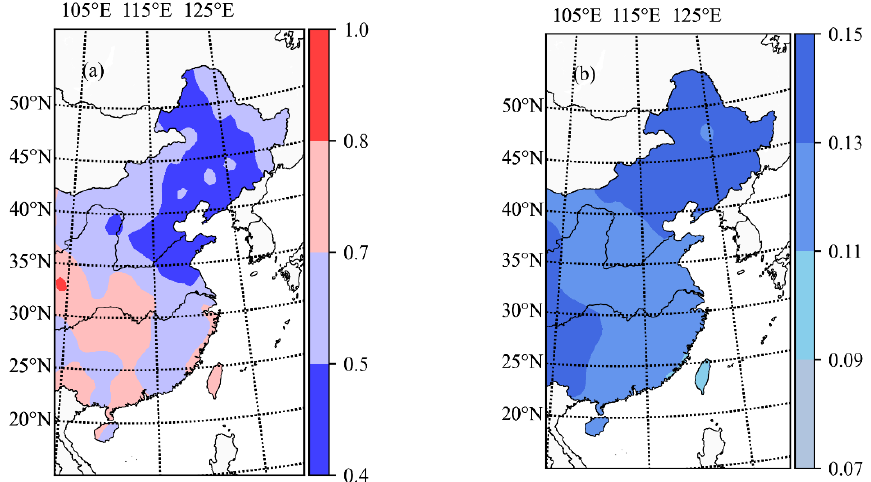
Figure 9. The occurring probability of different intensities precipitation events in the next mean quiet time: ( a ) UPEs; ( b ) EPEs.